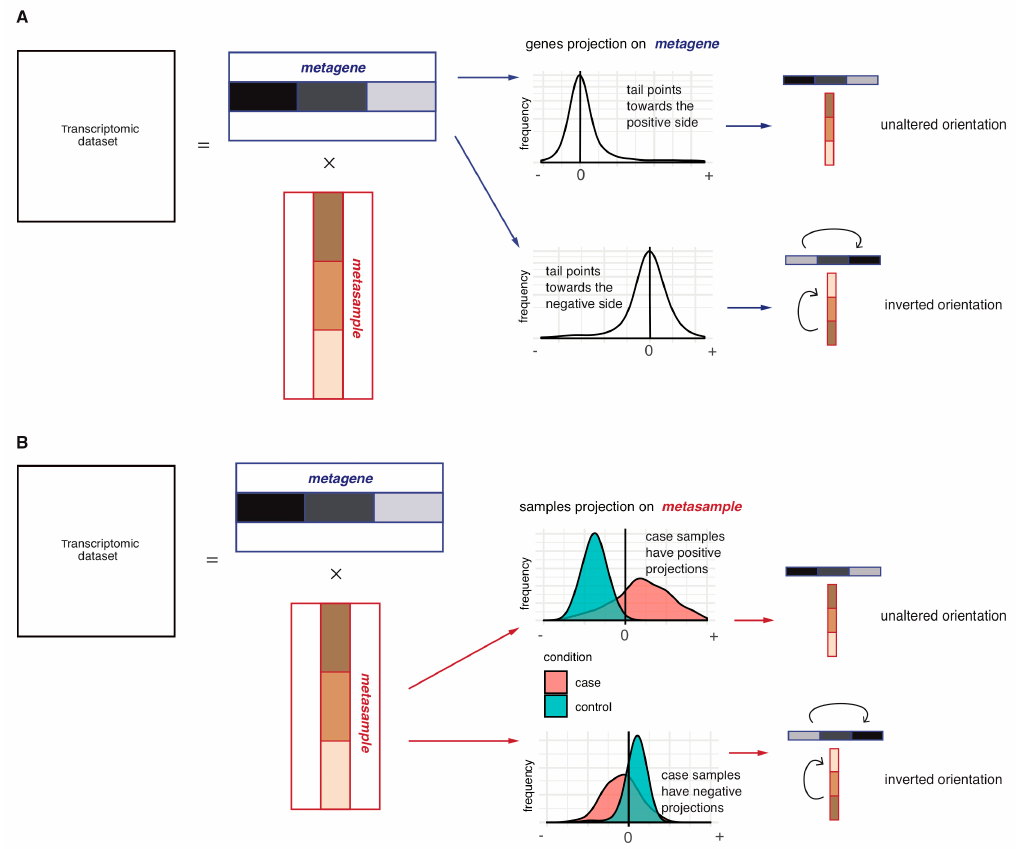
Figure 2. Schematic representation of the metagene orientation procedures: Long-tail-pointing ( A ) and disease-pointing ( B ). In ( A ), each couple (metagene, metasample) is oriented based on the distribution of the metagene weights. Two possible scenarios may thus be verified depending on the distribution of the weights constituting the metagene: if the long tail of the distribution is already in the positive side, no operation is performed; if instead the long tail is pointing in the negative direction, the orientation of the two vectors is inverted. In ( B ), each couple (metagene, metasample) is oriented based on the distribution of the metasample weights. Two possible scenarios may thus be verified depending on the case vs. control distribution of the weights constituting the metasample: if case samples have higher weights with respect to control samples, no operation is performed; in the opposite case, the two vectors are inverted.